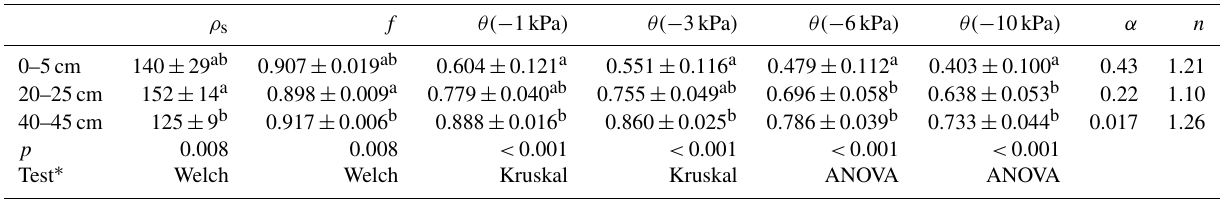
Table 1. Means and standard deviations for the bulk density ( ρ s , kgm − 3 ), total porosity ( f ), and volumetric water content ( θ ) of the peat samples at different matric potentials and the fitted van Genuchten water retention parameters α (cm − 1 ) and n .